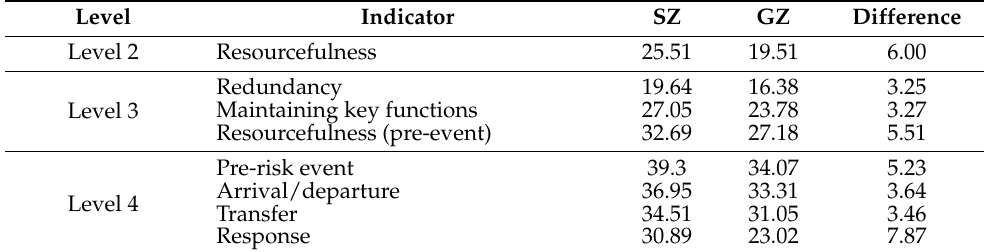
Table 5. Indicators of SZ and GZ (difference ≥